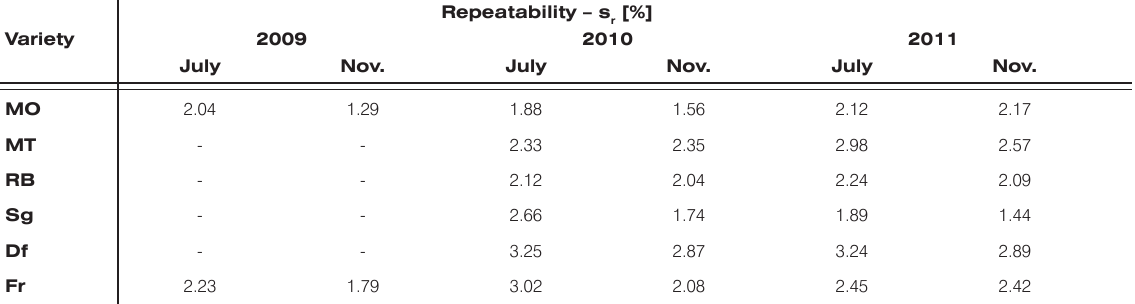
Table 1. Repeatability (relative standard deviations) of determinations for all varieties of vine in years of 2009, 2010 and